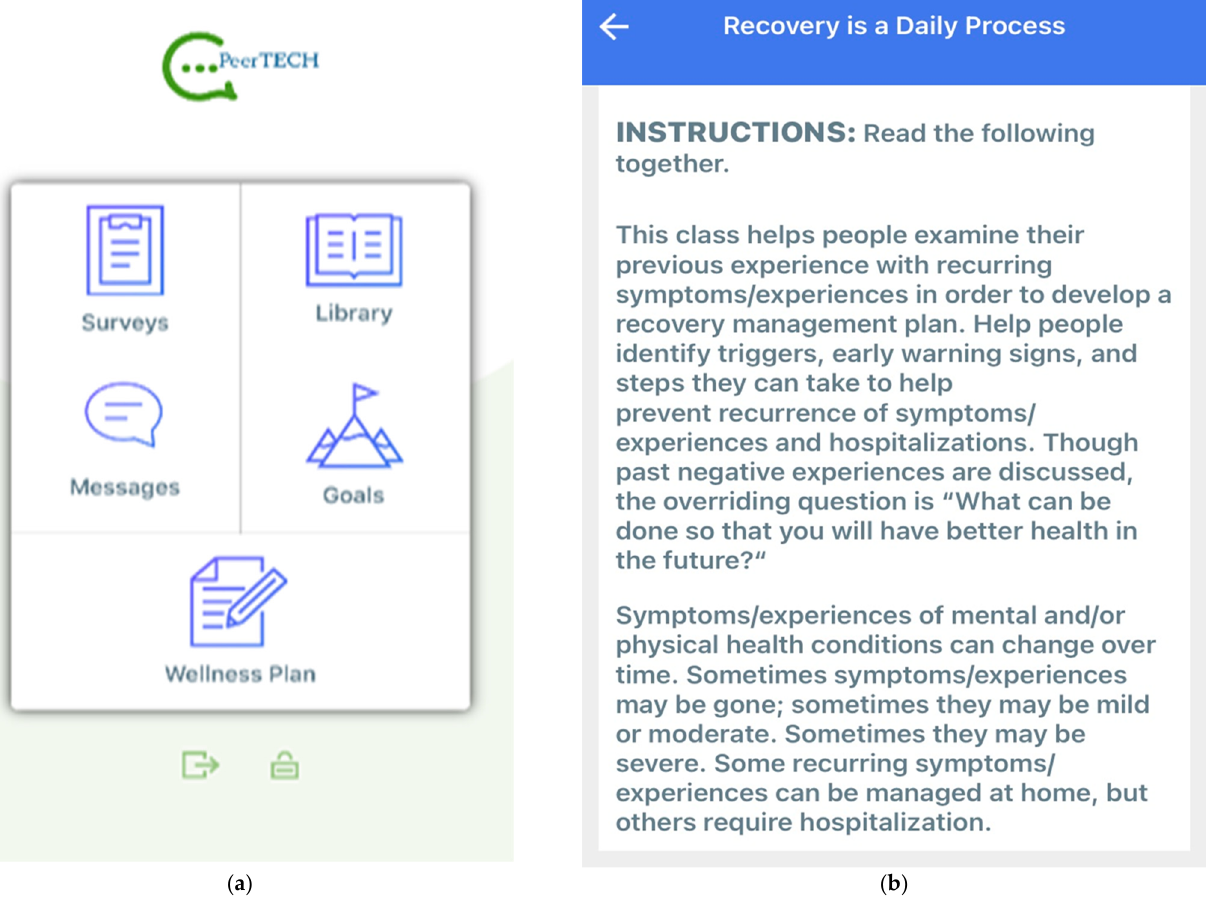
Figure 2. ( a ). Screenshot of the home screen in PeerTECH. ( b ). Screenshot of the instructions to the library module “Recovery is a Daily Process”.